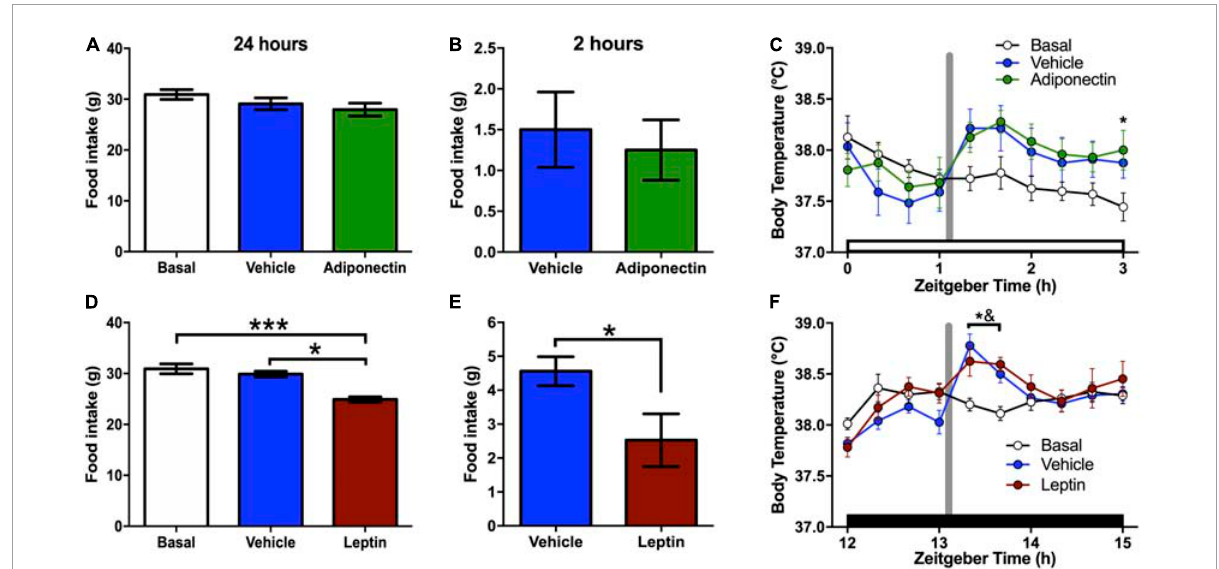
FIGURE4 Food intake and temperature responses after adipokines administration. (A,D) Food intake after 24 h of adipokines or vehicle administration compared with baseline data. (B,E) Food intake after 2 h of adipokines or vehicle administration prior to euthanasia. (C,F) Body core temperature after (C) adiponectin or (F) leptin administration. In food intake graphs: * P < 0.05, *** P < 0.001. In body temperature graphs: white bar, light phase; dark bar, dark phase; vertical gray line, a moment of the adipokine or vehicle administration; * P < 0.05 Adipokine vs. basal; & P < 0.05 vehicle vs.